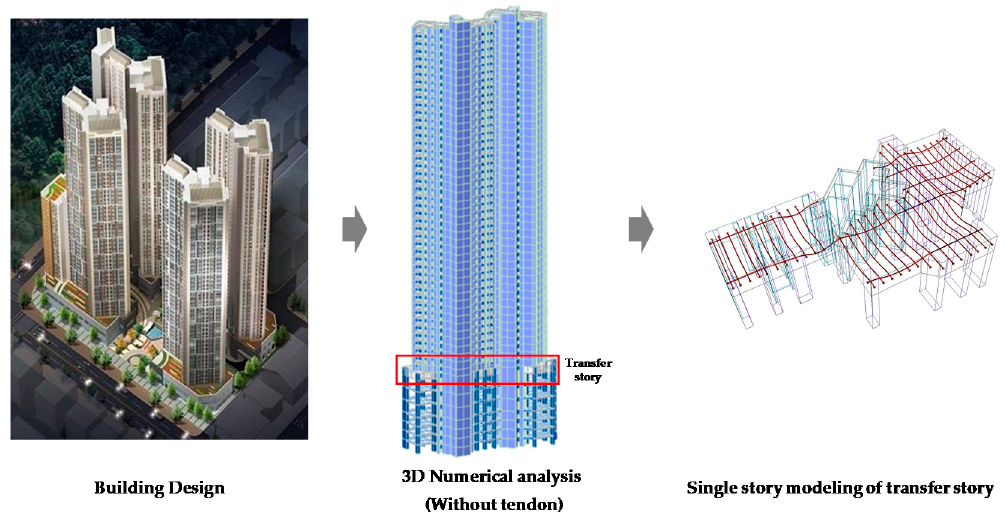
Figure 1. The analysis and design process for residential building with the post-tensioned transfer plate.